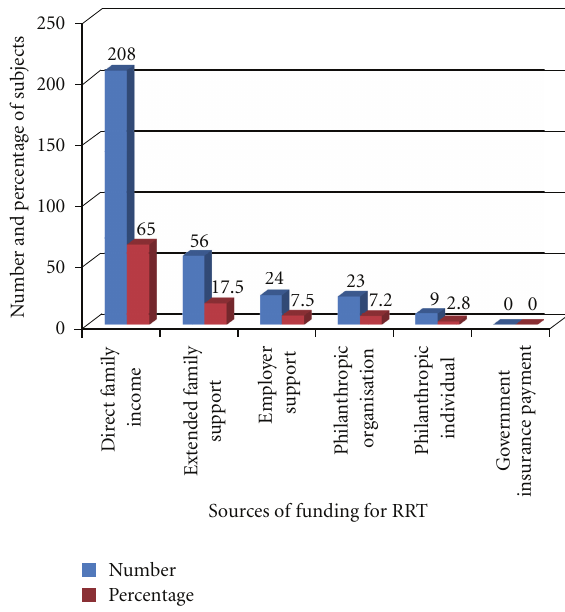
Figure 2: Chart showing sources of funding for ESRD